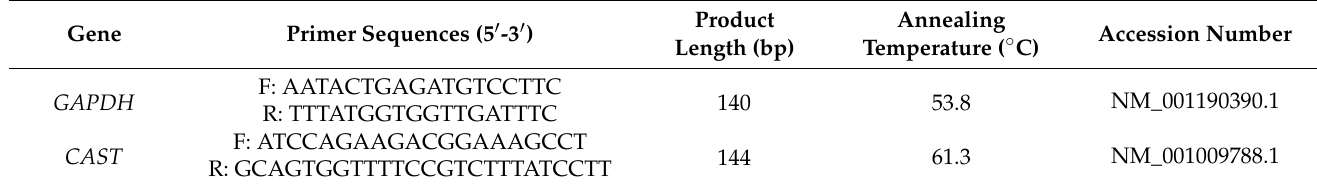
Table 1. The primers of GAPDH and CAST genes for real-time